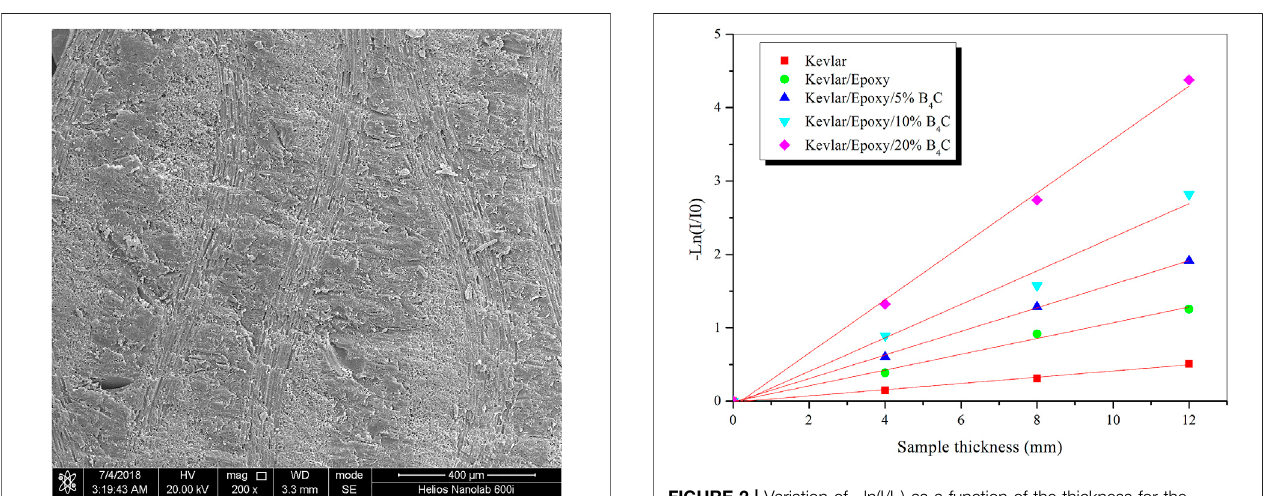
FIGURE 2 | Variation of − ln(I/I 0 ) as a function of the thickness for the studied